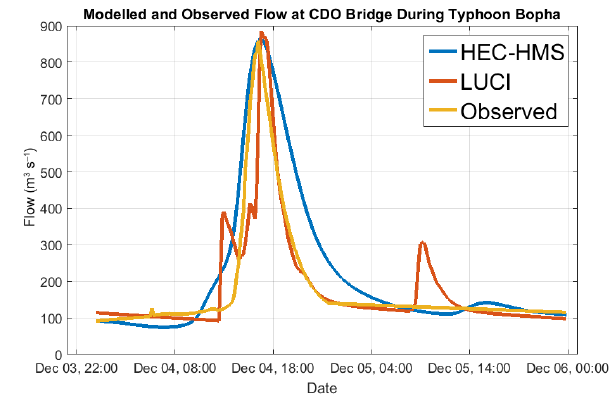
Figure 5. The modelled hydrographs from HEC-HMS and LUCI compared to the observed flow during Typhoon Bopha.